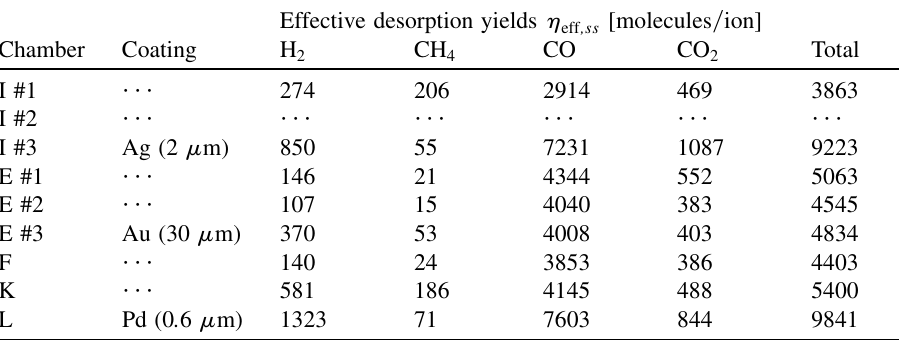
TABLE I. Effective desorption yields (cid:5) 4 : 2 MeV = u Pb 53 (cid:2) ions impacting under (cid:8) (cid:6) 89 : 2 (cid:7) grazing incidence. Normal incidence corresponds to (cid:8) (cid:6) 0 (cid:7)